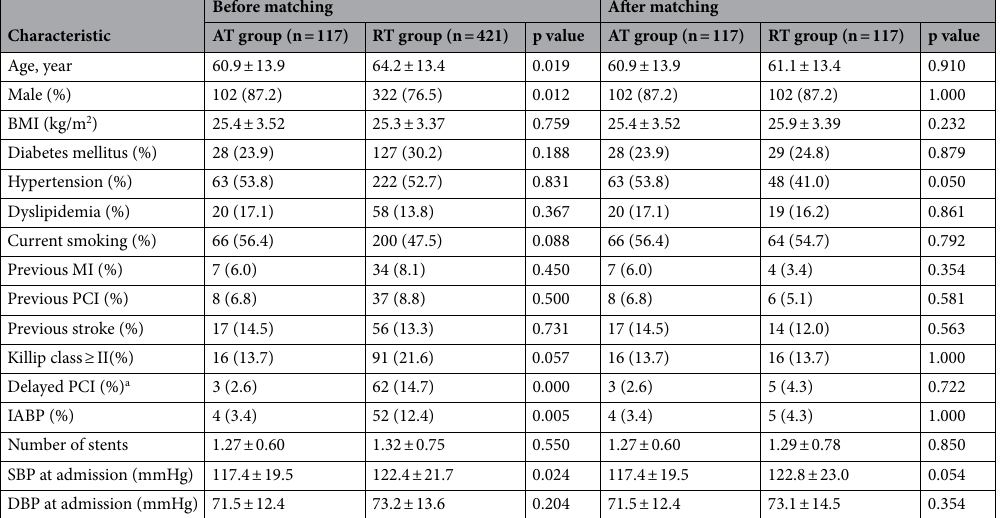
Table 1. Baseline characteristics before and after propensity-score matching. BMI body mass index, MI myocardial infarction, PCI percutaneous coronary intervention, IABP Intra aortic balloon pump, SBP systolic blood pressure, DBP diastolic blood pressure. a Delayed PCI: the time of PCI from symptom onset > 12 h.